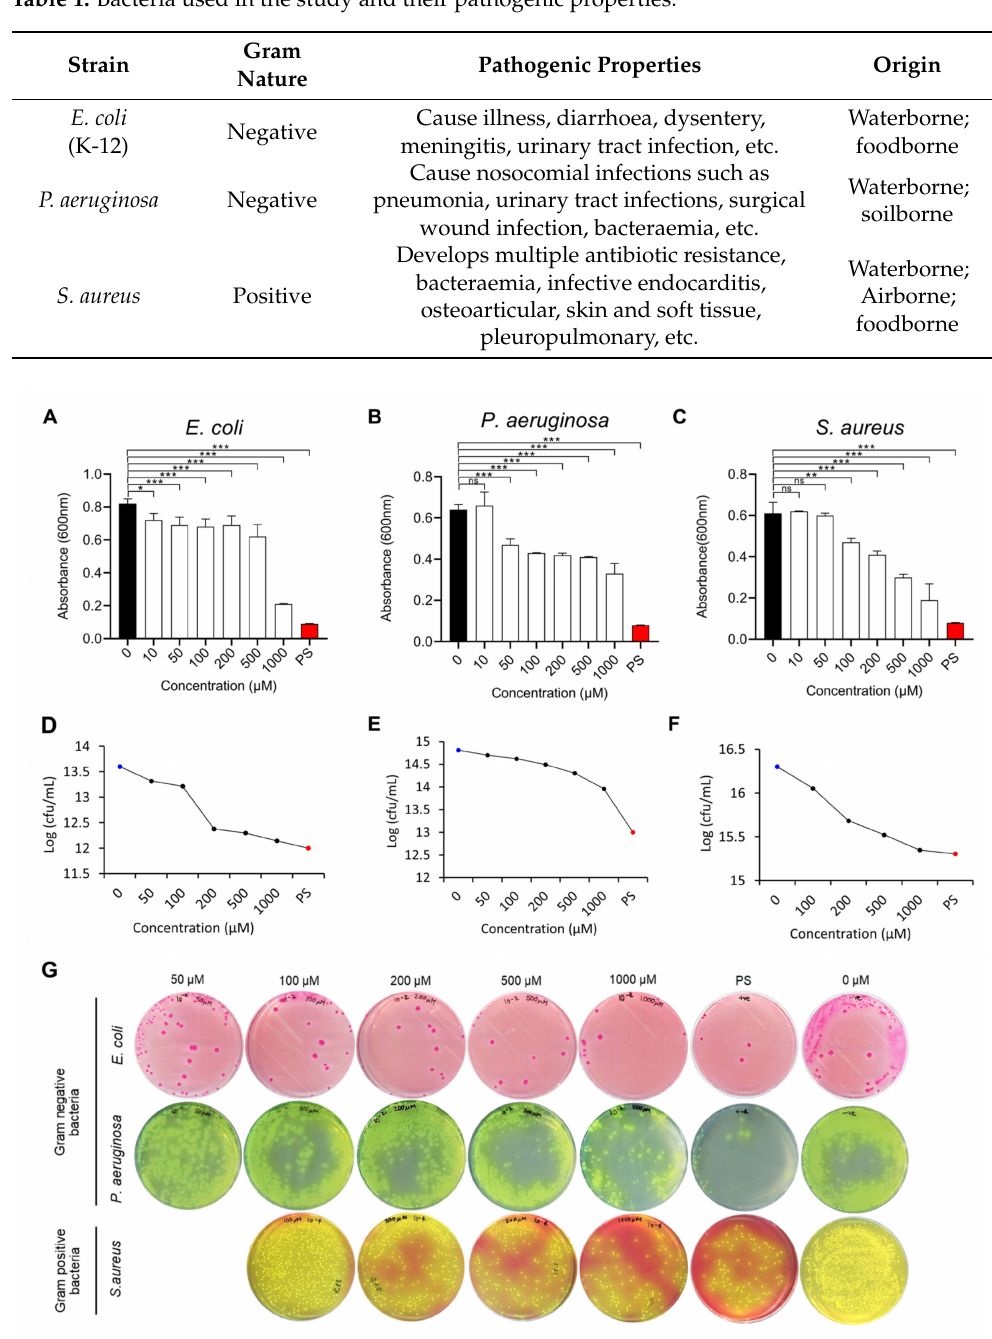
Figure 4. CFU assay of Gram-negative and Gram-positive bacteria treated with PG-NOW. ( A – C ) Determination of CFU using a microbroth dilution assay with a 1000, 500, 200, 100, 50, and 10 µ